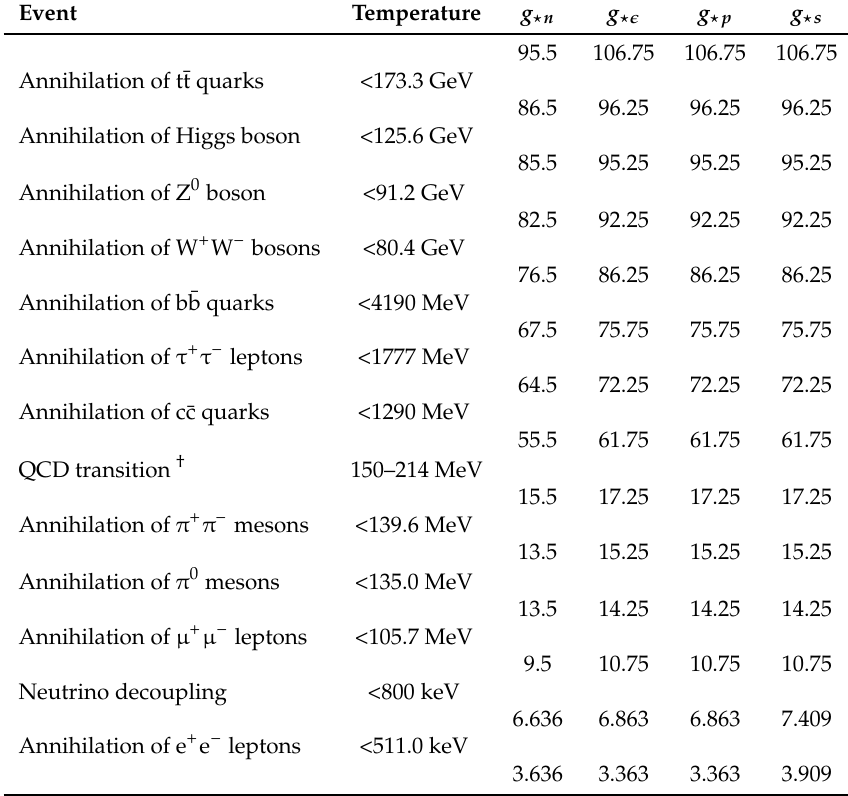
Table 2. List of events which impacts g ⋆ n , g ⋆ (cid:101) , g ⋆ p , and g ⋆ s . For the particle annihilation events, we have here used the particle masses as a reference. By combining this Table with Table B1 in Appendix B, we get a more precise